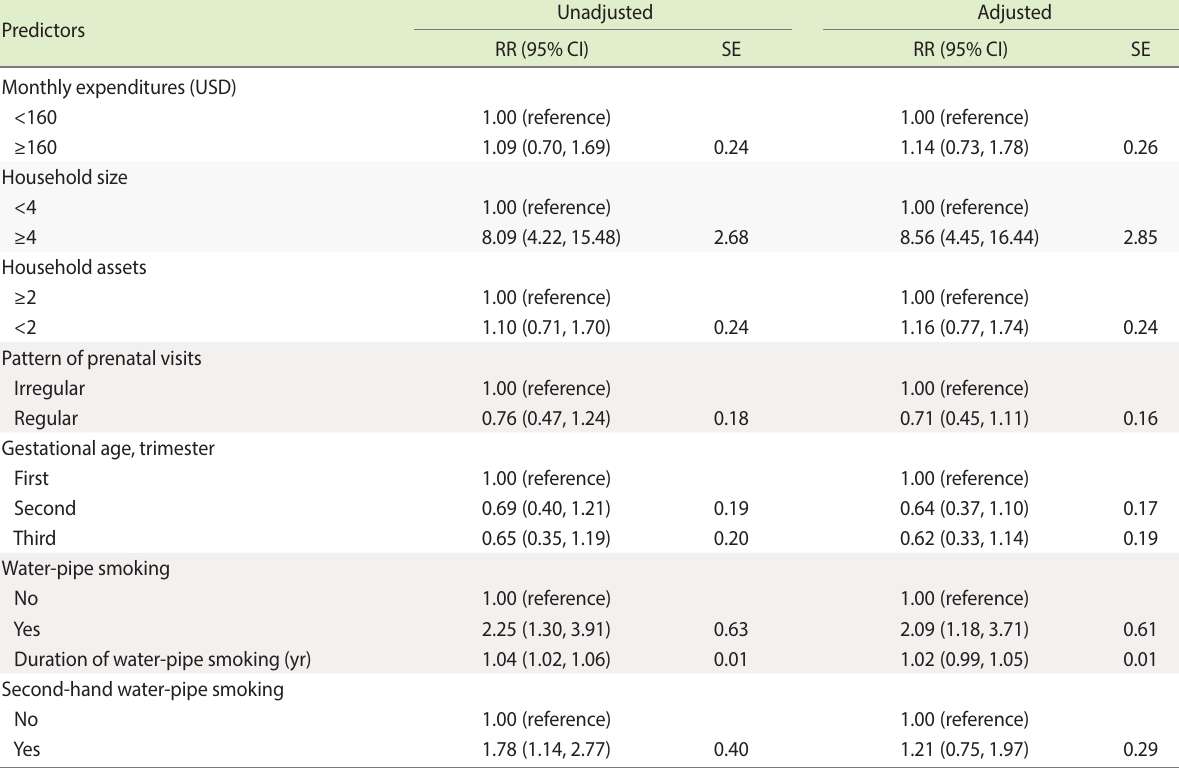
Table 3. The results of generalized linear models for low birth weight according to water-pipe smoking in pregnant women in Bandar Ab- bas,